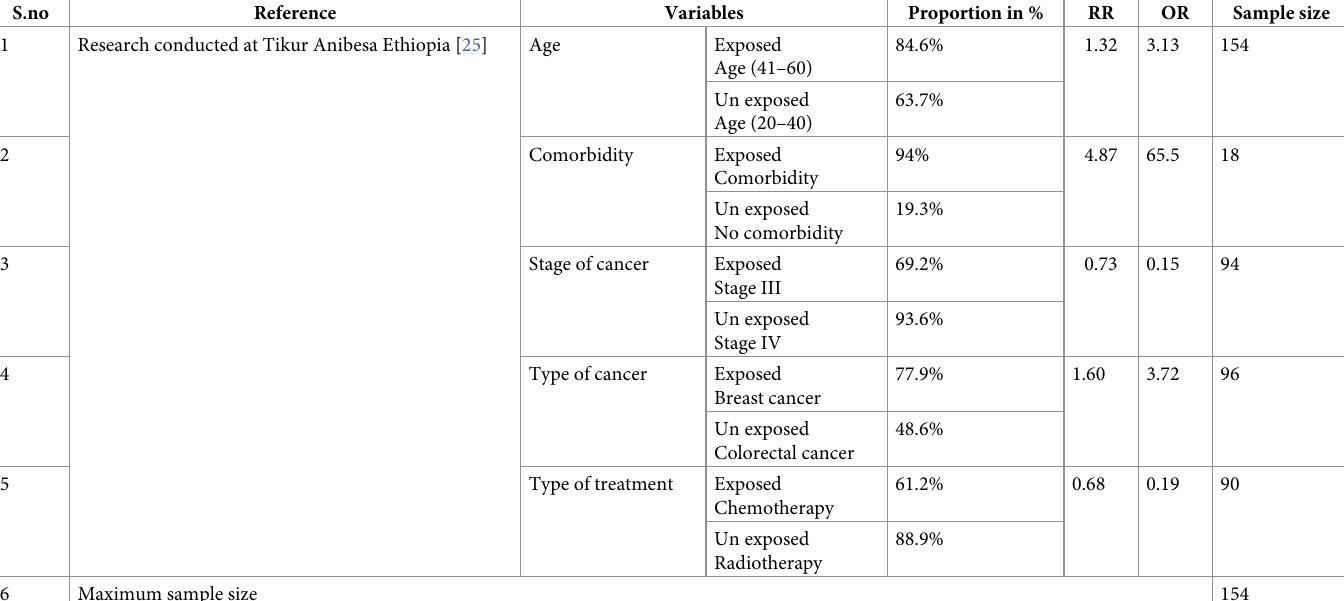
Table 1. Sample size determination based on second objective for fatigue and associated factors among adult cancer patients receiving cancer treatment at oncology unit in Amhara region, Ethiopia, 2022.